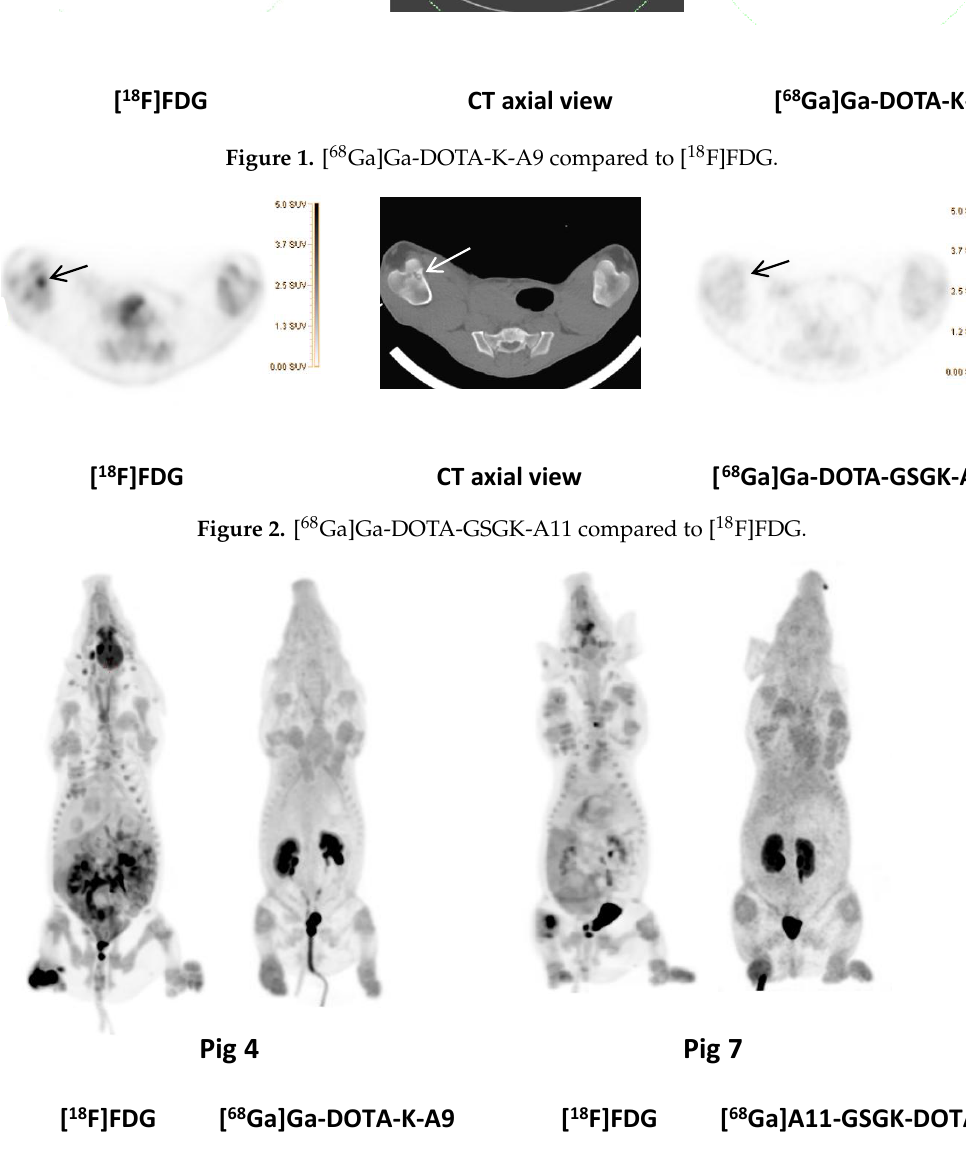
Figure 3. Maximum intensity projections (MIPs) of [ 18 F]FDG, [ 68 Ga]Ga-DOTA-K-A9, and [ 68 Ga]Ga-